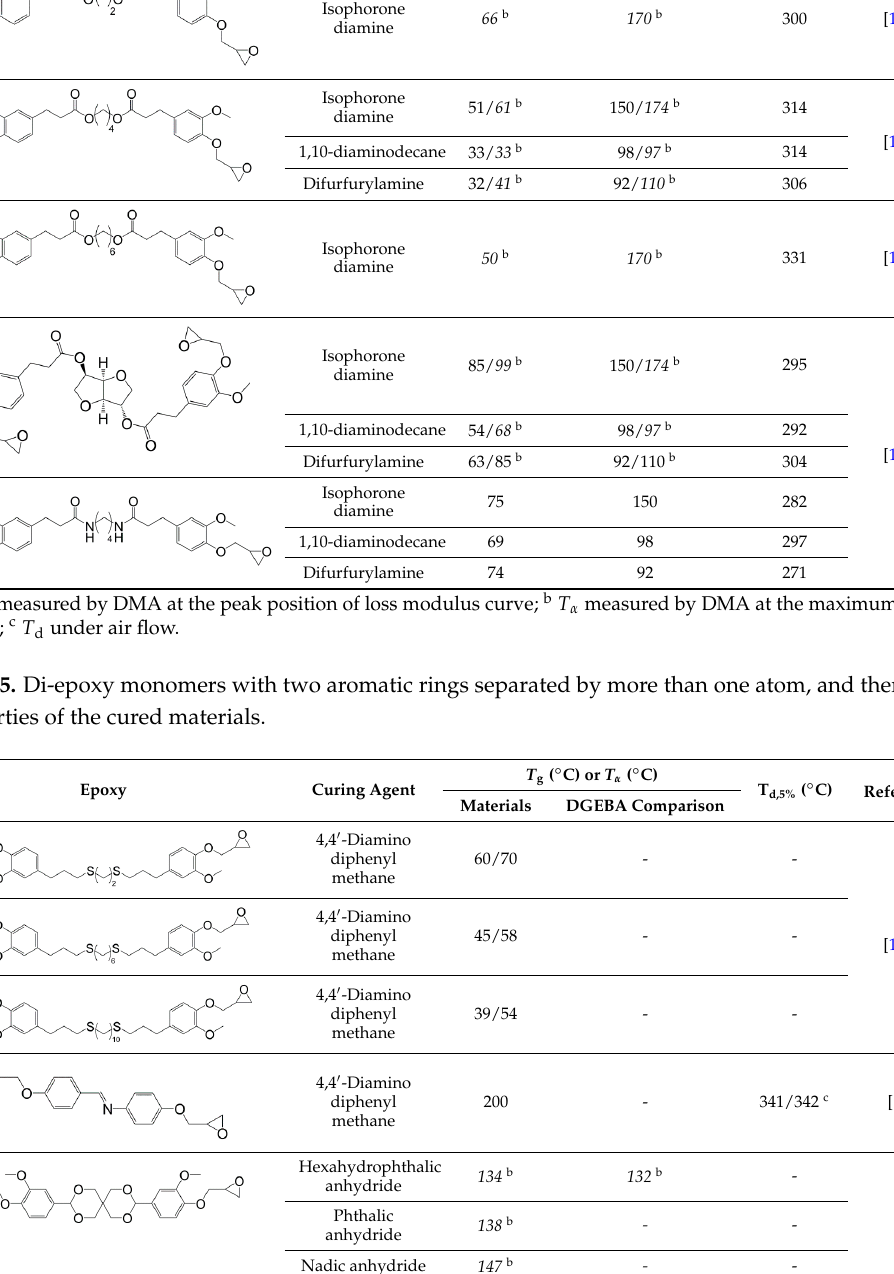
Molecules 2017 , 22 , 149